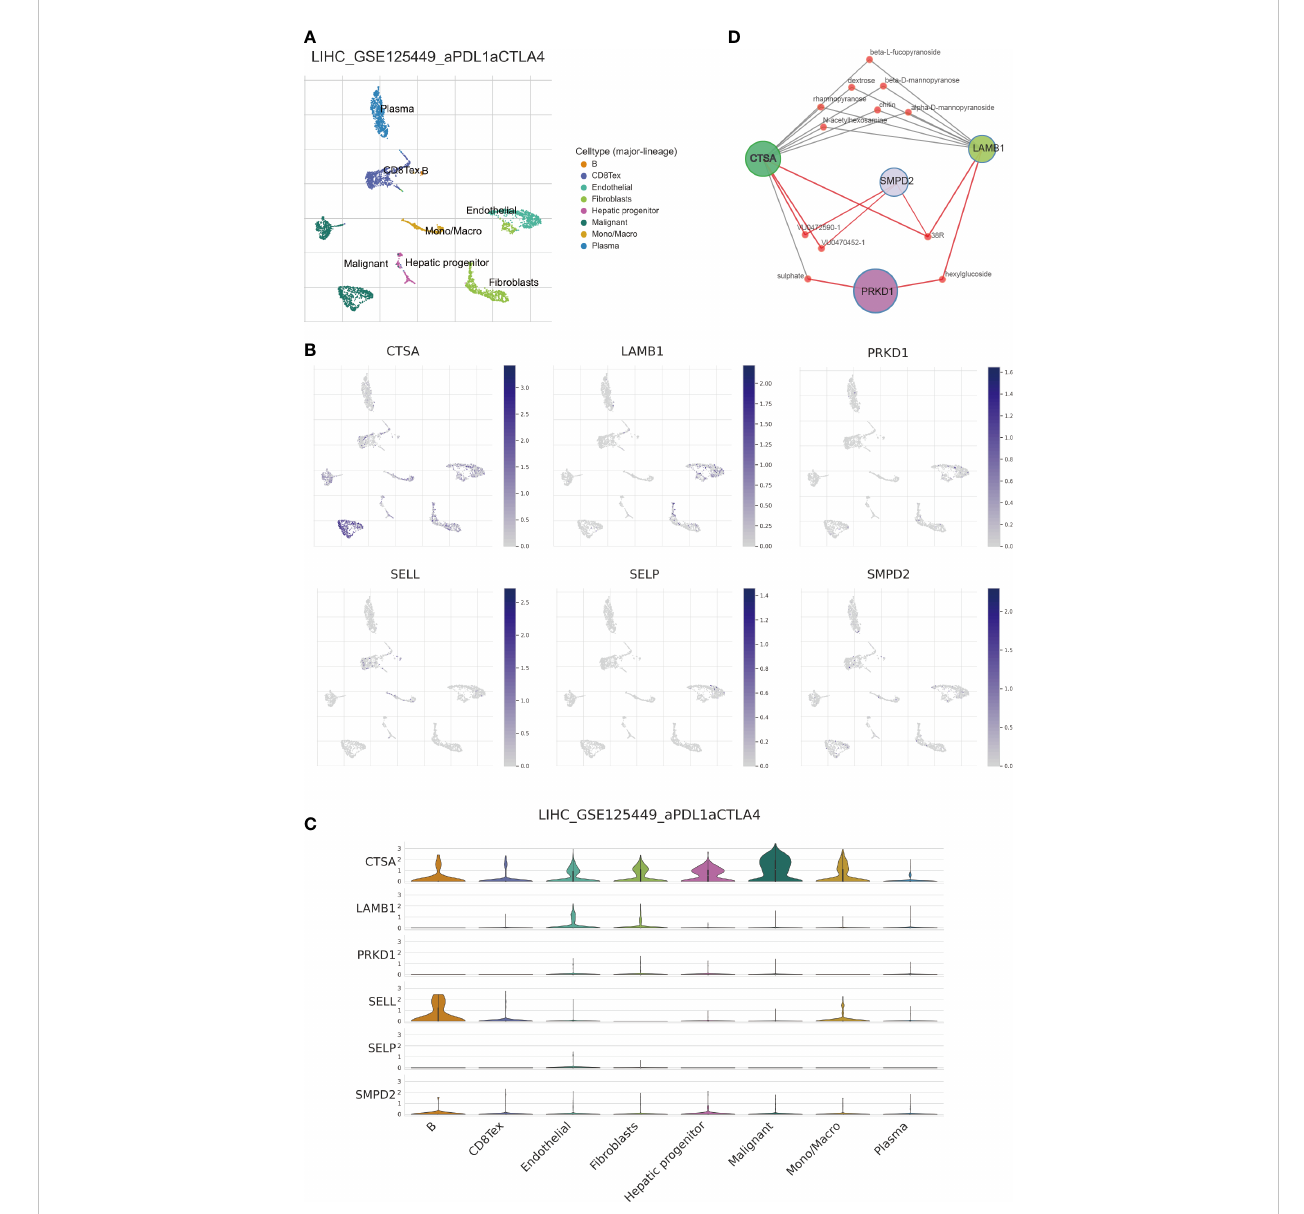
FIGURE 12 Single-cell analysis of 6-SPGs expression patterns. (A) GSE125449 annotation of all cell types and percentage of each type. (B, C) Percentages and expressions of 6-SPGs in HCC tissues. (D) Prediction of targeted drugs for four highly expressed SPG